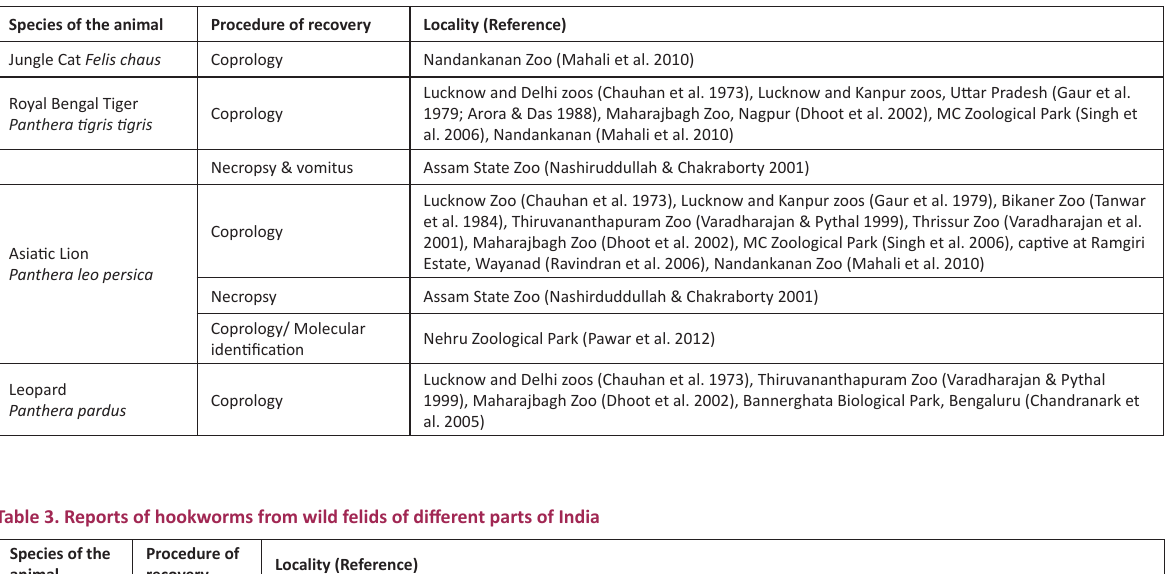
Table 2. Reports of Toxascaris leonina in wild felids